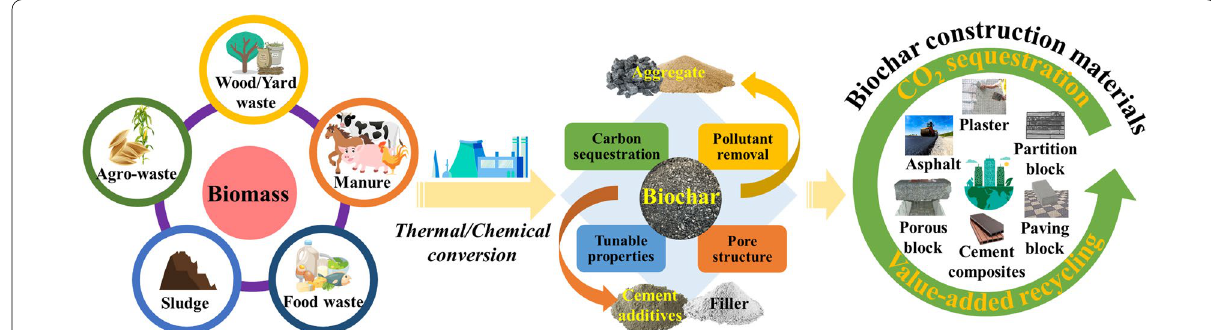
Fig. 3 Upcycling of waste biomass into carbon-negative biochar construction